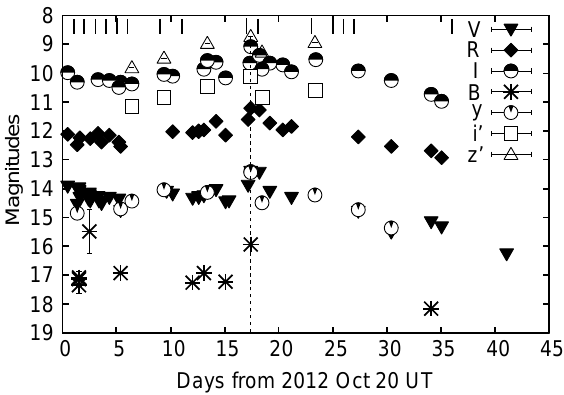
Figure 2: Optical light curves of V1724 Aql obtained at KAO with the multi-band light curves of the nova taken from AAVSO database. The vertical tick-marks at the top of panel indicate the dates of our spectro- scopic observations.